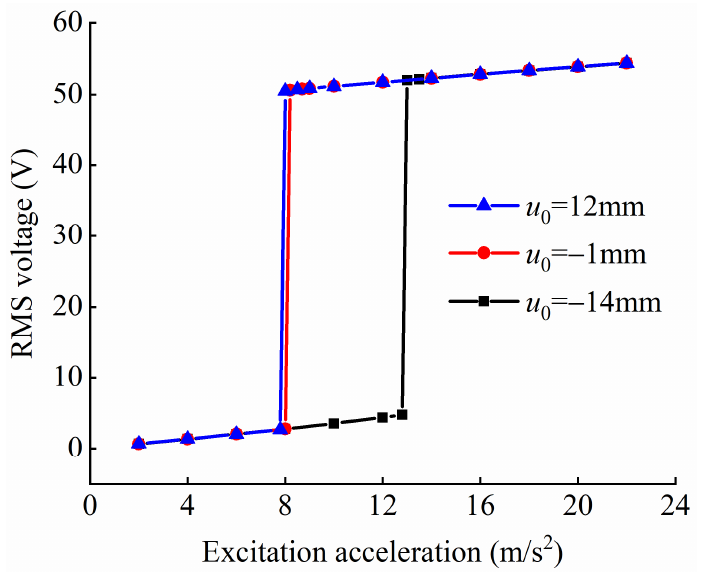
Figure 10. Excitation acceleration threshold of the system under different u 0 .